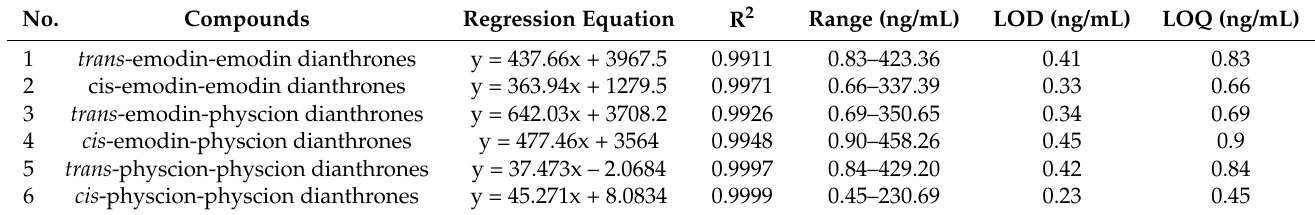
Table 4. Regression equation, range, LOD, and LOQ of the six compounds in the detection of total